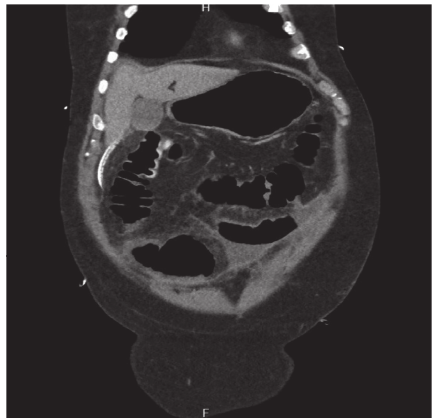
Figure 6: CT abdomen showing extravasation of contrast material.